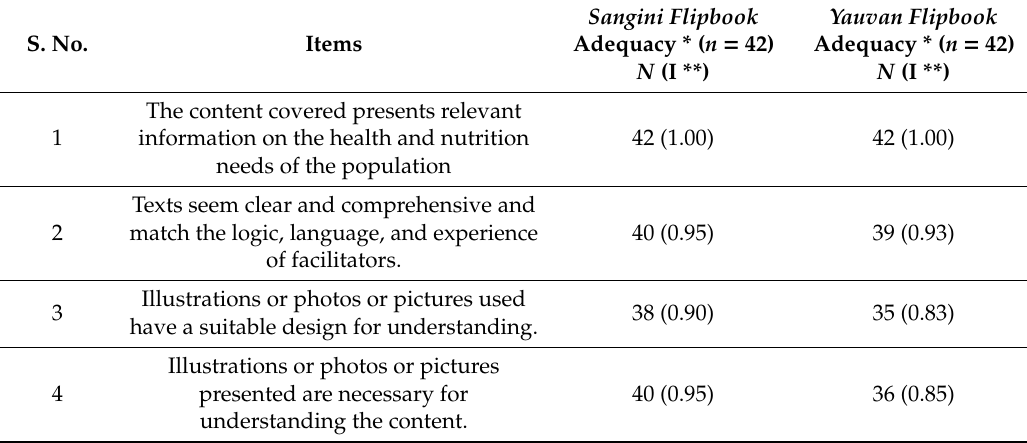
Table 2. Evaluation of adequacy of agreement on the flipbook content and layout (content validity; I—index). BCC—behavior change